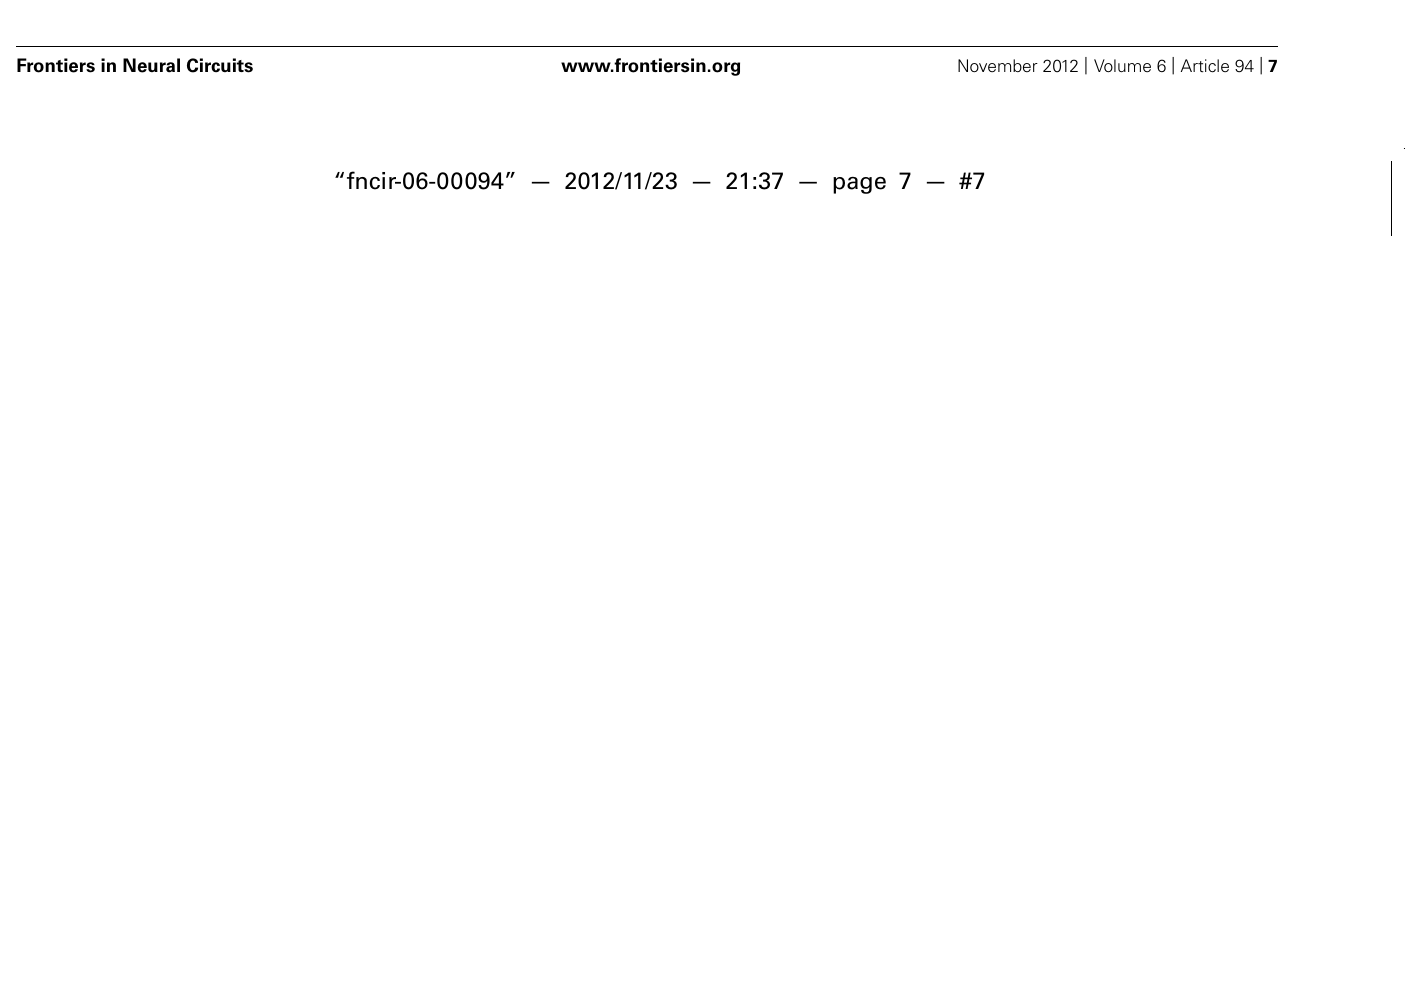
engaged neurons.The average number of spikes time-histogram (SNTH) shows activity originating in each cluster at a resolution of 10 ms.The cumulative time histogram shows the average number of engaged neurons (cNNTH) in bursts (bin of 100 ms; (see Materials and Methods).Thus, different types of information on network activity could be studied: the first about the type of firing (average number of spikes in the burst) and the latter monitor the evolution during the burst life-time of the spikes elicited by each neuron (Gullo etal., 2012). (B 2 ,C 2 ,D 2 ,E 2 ) Plot of cFSH, EXTH, SNTH and NNTH histograms, respectively, during the 10 nMTHDOC application. Same as in upper panels, but are shown also the plots of the second state (lowest part as indicated by the vertical left legend).Thin superimposed lines show control data from upper panels for